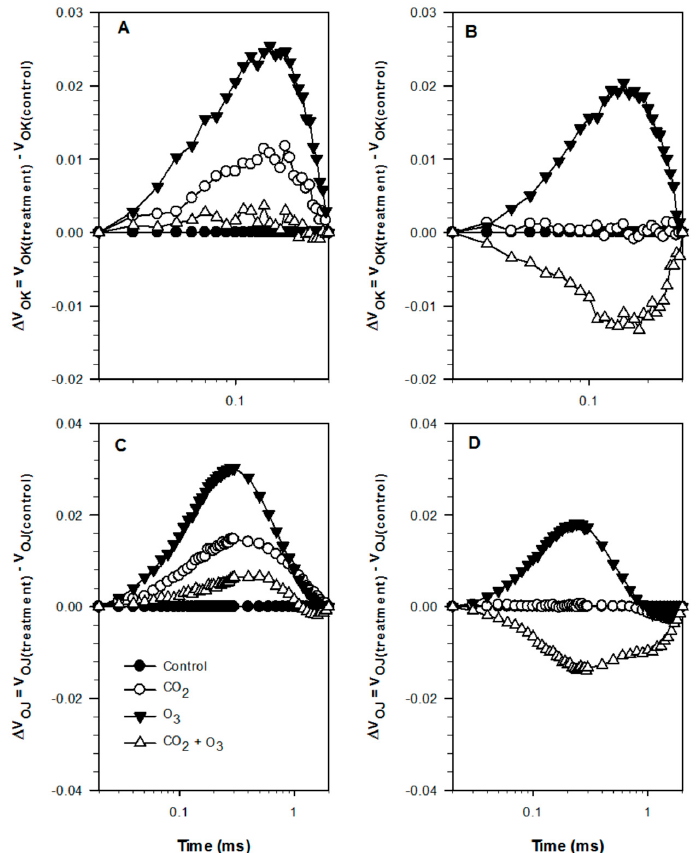
Figure 2. Effect of elevated CO 2 , O 3 and the combination of CO 2 and O 3 on differential plots of relative chlorophyll a fluorescence ( Δ V t ) under well-watered ( B and D ) and water-stressed conditions ( A and C ) in leaves of canola. The data represent the average of all weeks. A – B , Δ V OK = V OK (treatment) − V OK (control) ; C – D , Δ V OJ = V OJ (treatment) − V OJ (control) .